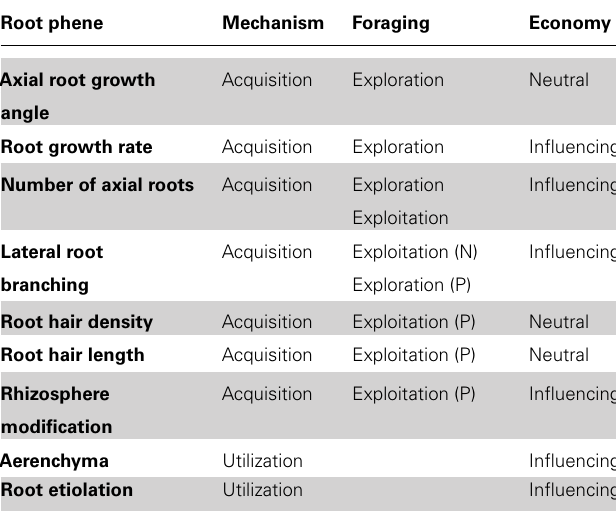
Table 1 | Classification of root